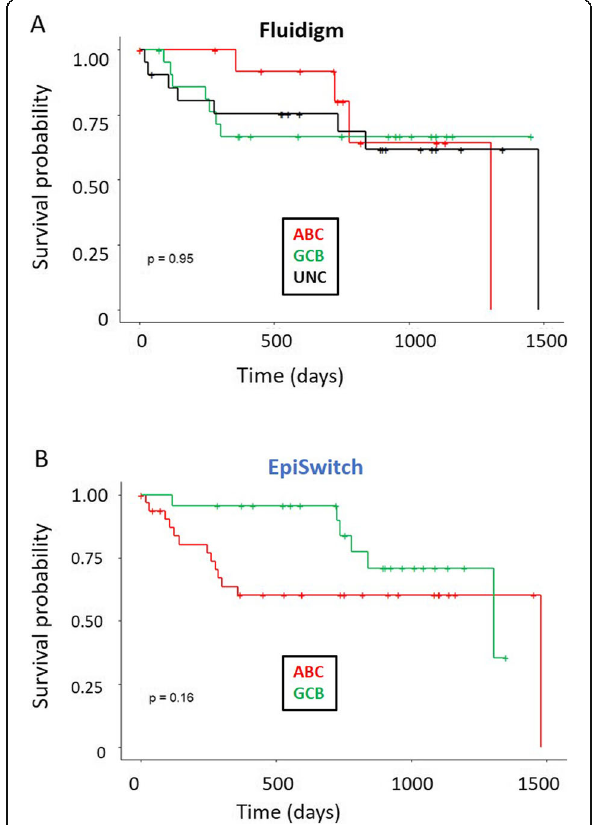
Fig. 5 Comparison of baseline DLBCL subtype calls in Type III samples using EpiSwitch and Fluidigm with long term survival. Kaplan-Meier survival curves for the 58 DLBCL patients classified as either ABC (red), GCB (green) or Unclassified (UNC, black) by the Fluidigm assay ( a ) or the EpiSwitch DLBCL-CCS ( b ). Fluidigm classified 15 samples as ABC, 22 as GCB and 21 were UNC. EpiSwitch classified 34 as ABC and 24 as